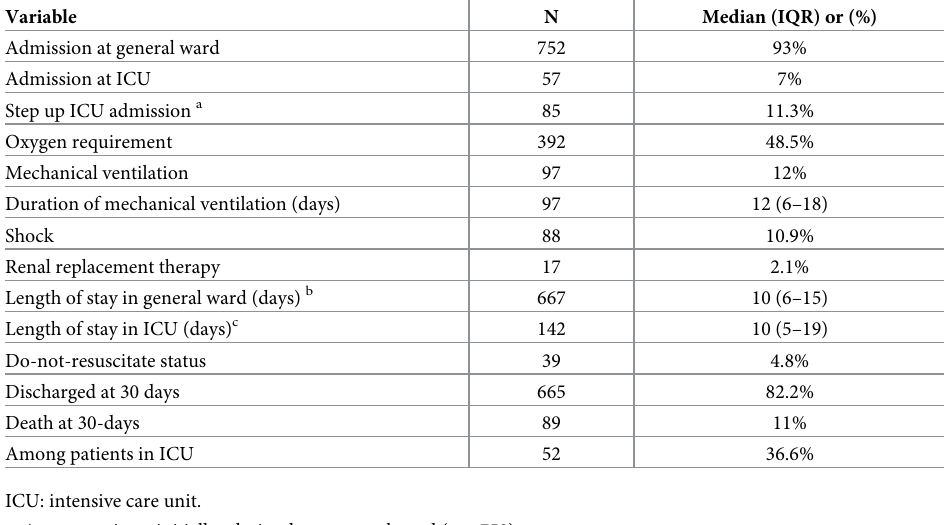
Lemeshow X 2 = 8.4, df = 7, p-value = 0.30) ( Table 5). Factors at admission independently asso- ciated with 30-day mortality in the multivariable model included age � 60 years-old (OR 2.68;